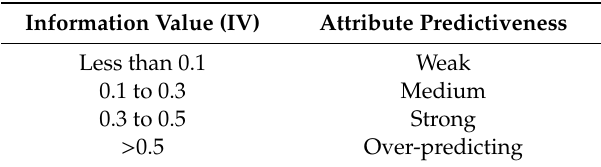
Table 1. Interpretation of information